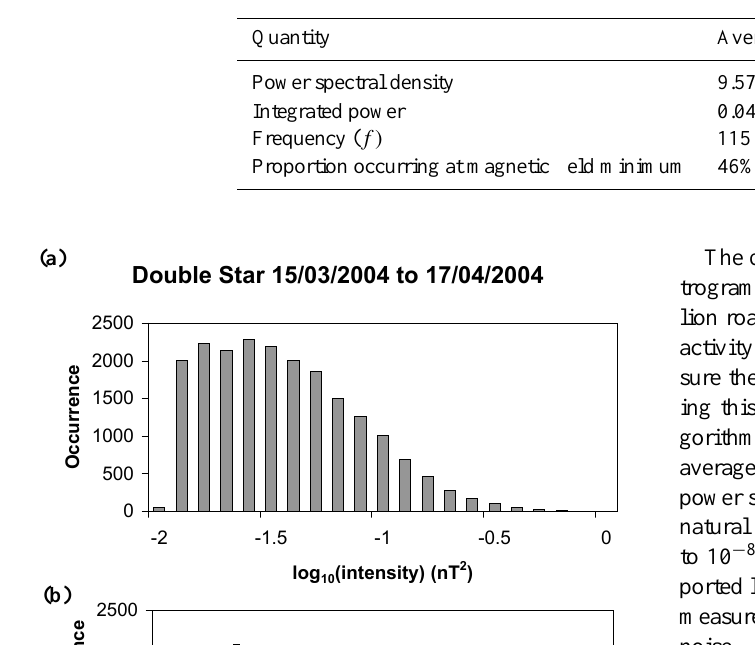
Table 1. Average lion roar intensity, wave frequency, and proportion occurring at magnetic field minimum.